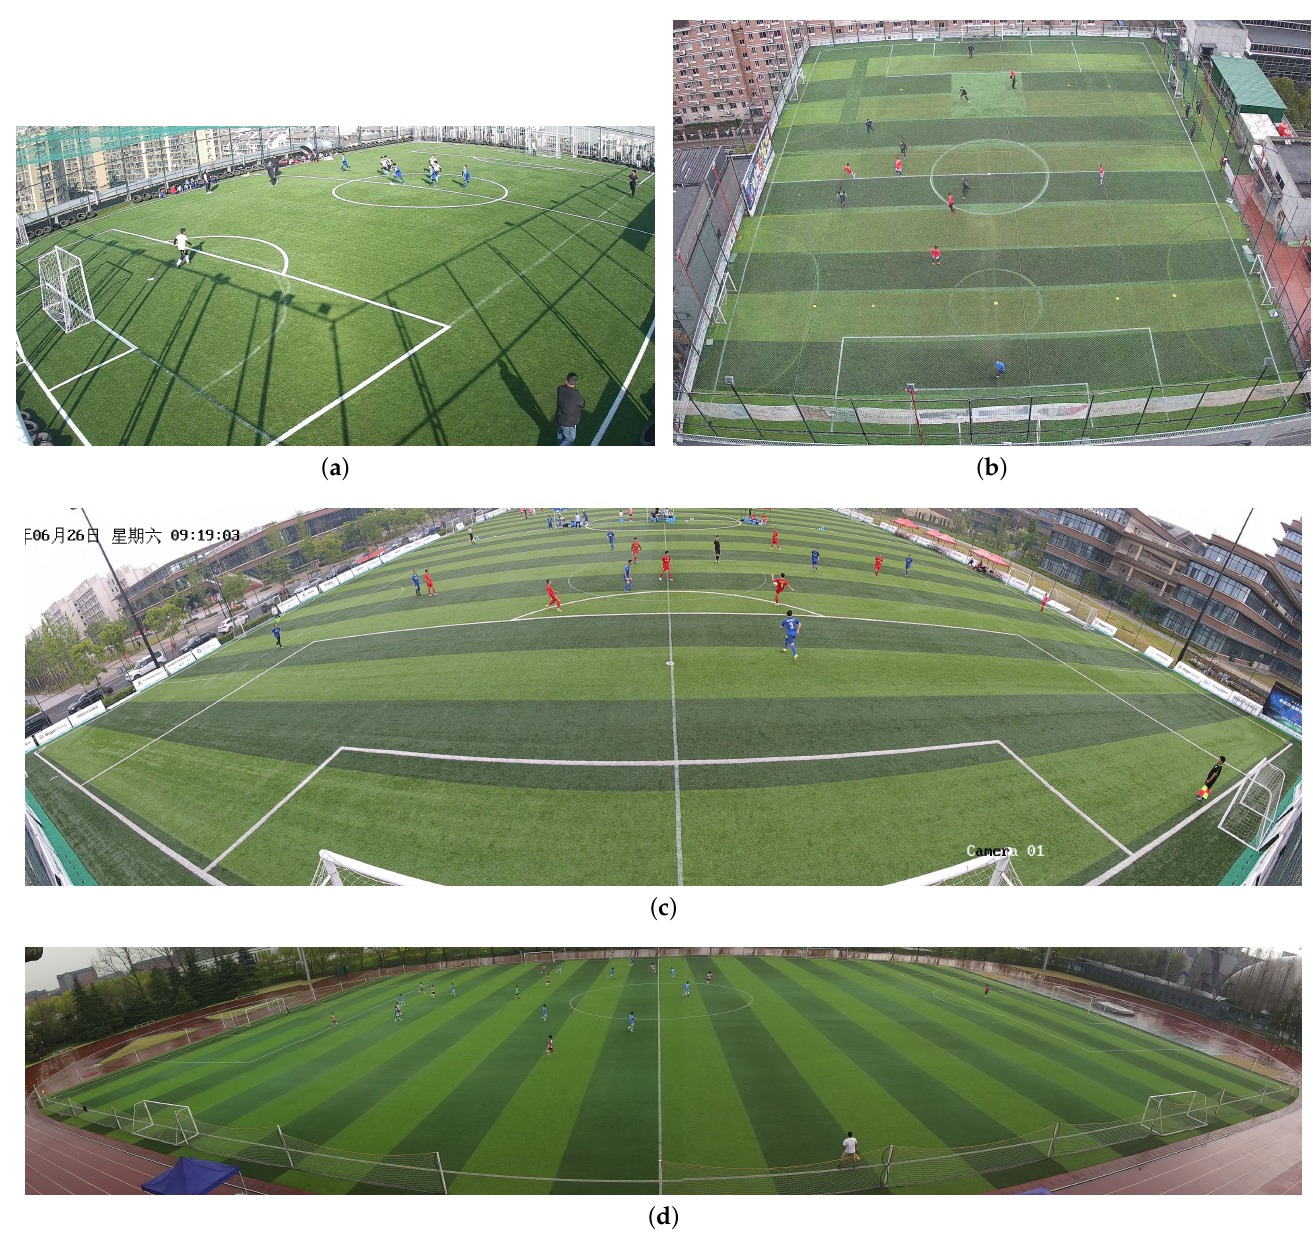
Figure 1. Pannels ( a – d ) correspond to the camera images of different venues respectively, illustrating how we installed the cameras. The above pictures only capture the effective area in the camera picture, which can increase the proportion of the target in the picture, thereby reducing the computational overhead and improving the operating efficiency and quality. ( a ) 5-a-side: Set up a high-resolution camera 3 m away and 5 m high from the corner point. ( b ) 7-a-side: Set up a high-resolution camera 5 m away and 18 m high from the post line. ( c ) 8-a-side: Set up a 180 ◦ high-resolution camera 1 m away and 6 m high from the middle-side-line. ( d ) 11-a-side: Set up a 180 ◦ high-resolution camera 15 m away and 15 m high from the